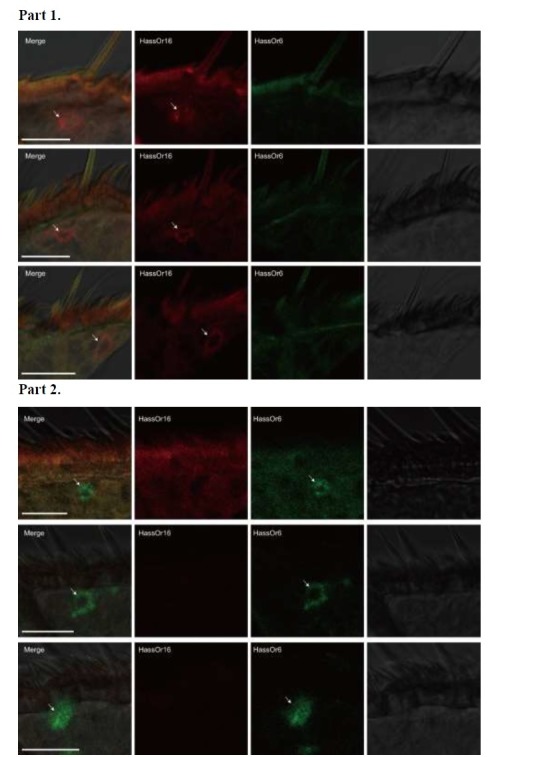
Two-colour in situ hybridization visualizing the combinations of HassOr16 and HassOr6 in male antennae of H. assulta.Arrows indicate the cell location. Scale bars: 20 μm.